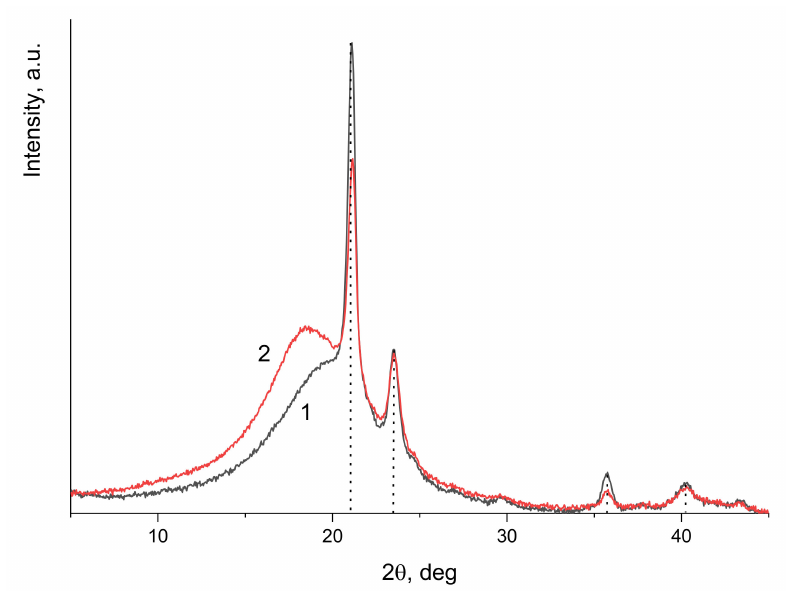
Figure 3. XRD patterns of (1) PCDD homopolymer and (2) NB–CDD C1 copolymer.